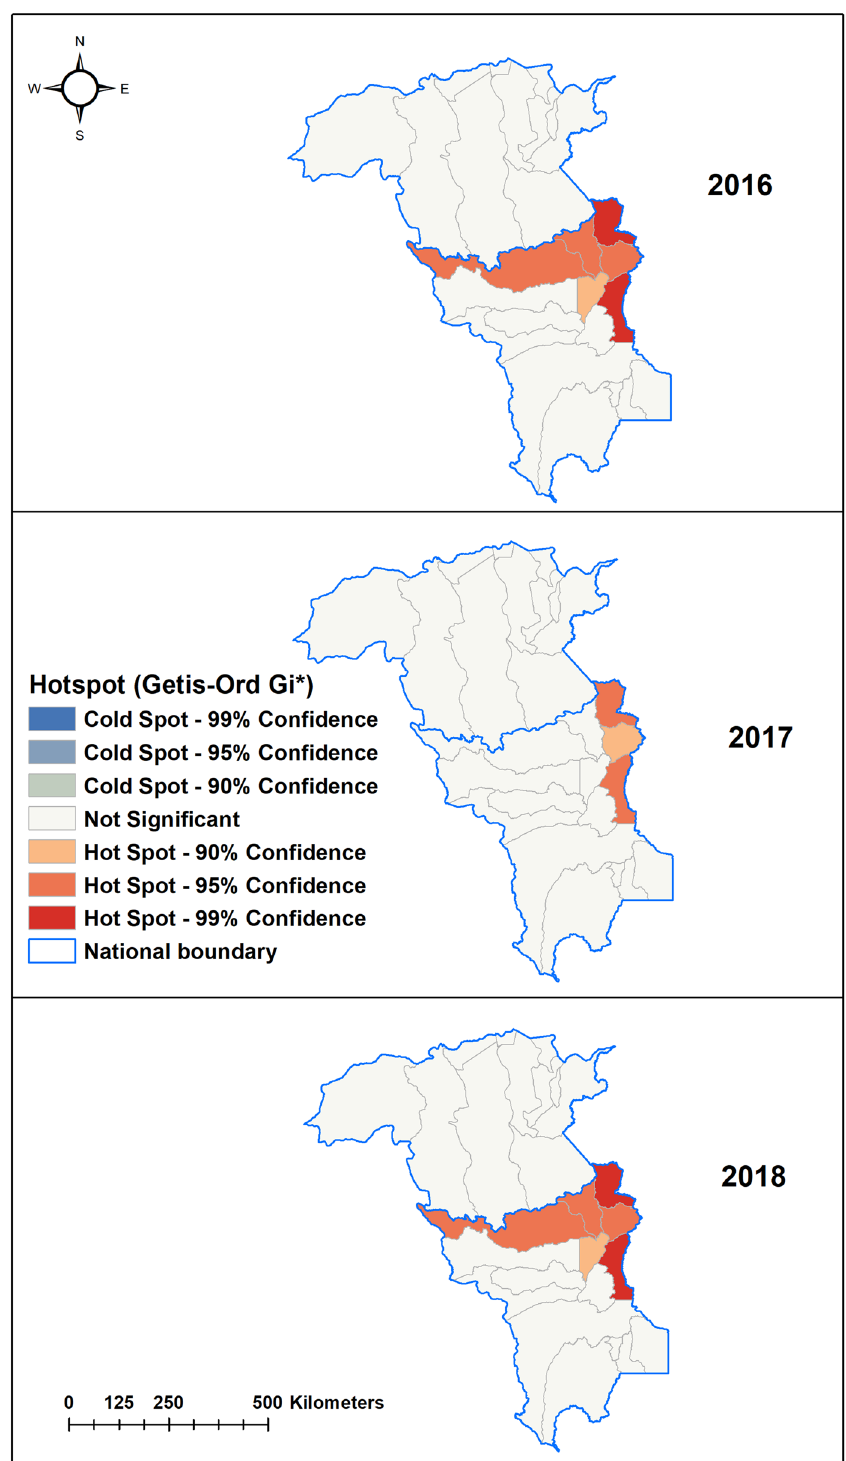
Figure 5. Hot spots (Getis-Ord Gi*) of imported malaria cases by municipalities in Roraima and Bolivar states,